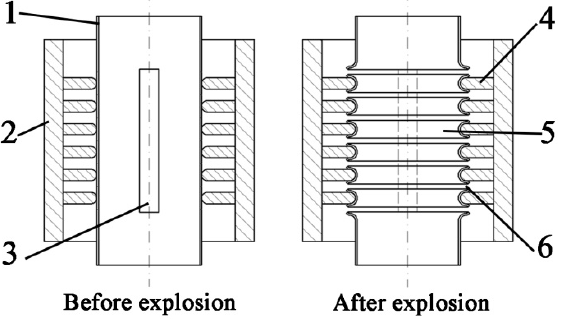
Figure 2. Formation of the Barrel Conductor in operation: 1 Barrel Conductor, 2 Epoxy Barrel, 3 Explosive, 4 Support Epoxy, 5 Rings, 6 gaps.